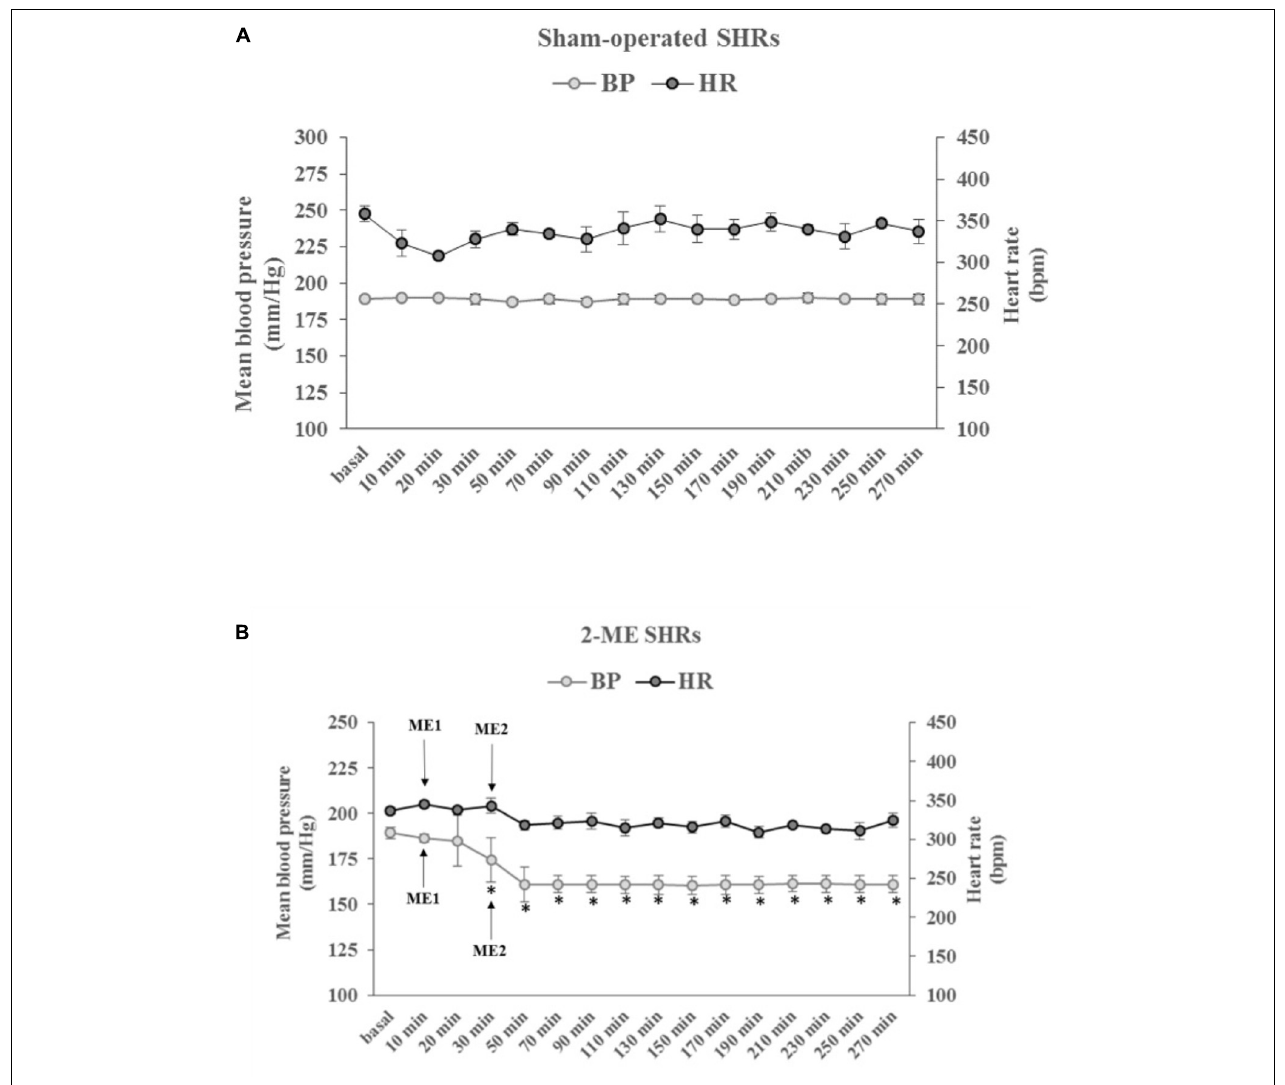
FIGURE 2 | The time-courses, in SHRs, of the mean blood pressure (BP, left ordinate axis) and heart rate (HR, right ordinate axis) in (A) SO rats ( N = 2) and (B) 2-ME ( N = 3) rats. ME1 and ME2 with arrows indicate the timing of ME treatments. Values (means ± SEM) are plotted every 10 min for the first 30 min after baseline values (basal) and every 20 min, thereafter. ∗ p < 0.001 vs. baseline